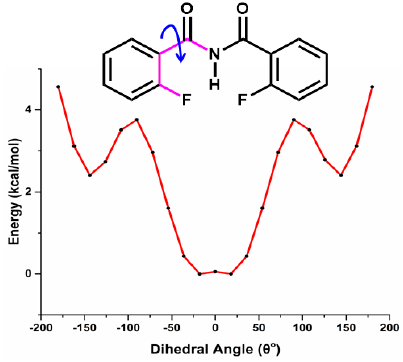
Figure 31. Relaxed potential energy surface for the internal rotation of the phenyl ring through single bond. The dihedral angle and rotation direction are highlighted in the structure of molecule 26 .